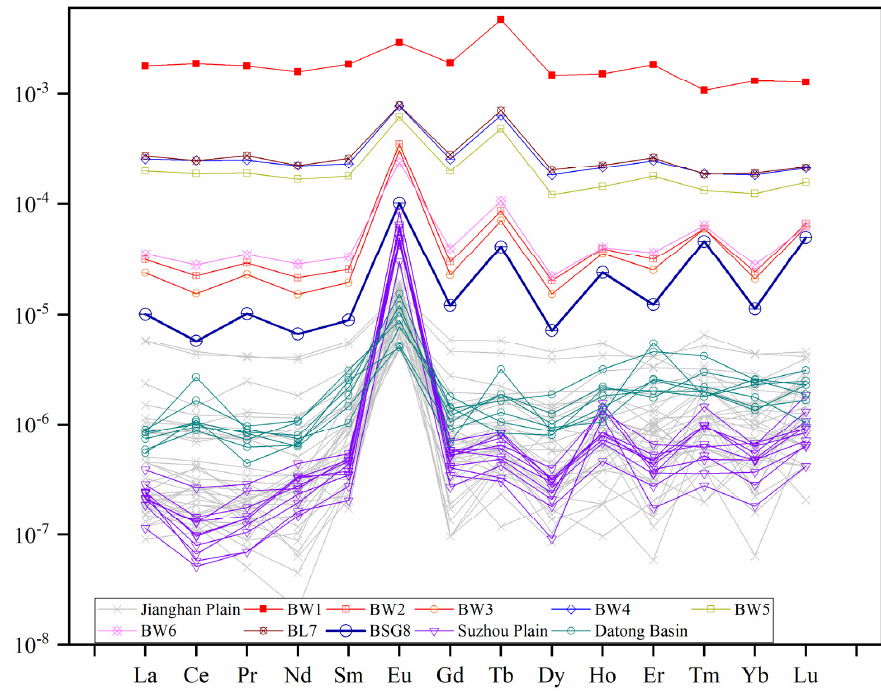
Figure 4. North American shale calculated (NASC) REE patterns in groundwater from the study area and other plains.